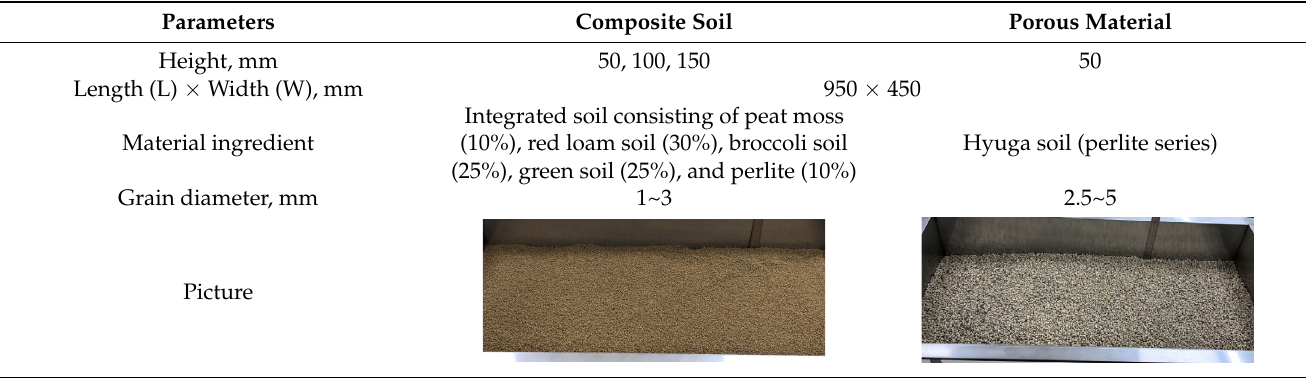
Table 1. Design specification of an active soil filter.